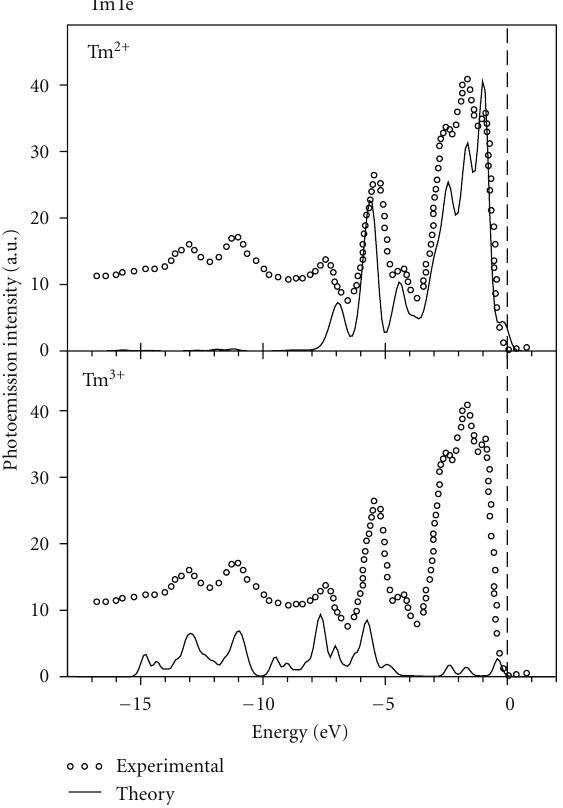
Figure 69: Comparison of the calculated Tm 2+ and Tm 3+ 4 f DOS of TmTe in LSDA+ U approximation [384], taking into account the multiplet structure of 4 f 12 and 4 f 11 final states with the experimen- tal UPS spectra from